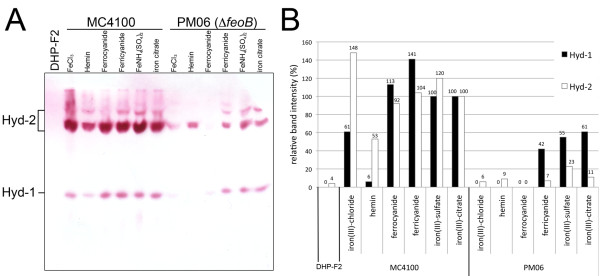
Effect of different iron supplements on Hyd-1 and Hyd-2 activities in PM06 (feoB::Tn5) after growth in M9 minimal medium. (A) Aliquots of crude extracts (25 μg) derived from DHP-F2 (negative control) the wild type (MC4100) and PM06 grown anaerobically in M9 minimal medium with glucose and the iron sources indicated were separated by non-denaturing PAGE (7.5% w/v polyacrylamide) and subsequently stained for hydrogenase enzyme activity (see Methods). The iron sources were the following: 7.5 μM FeCl3; 15.3 μM hemin; 50 μM iron citrate (C6H5FeO7) (Fe3+); 10 μM potassium ferrocyanide (K4[Fe(CN)6]) (Fe2+); 10 μM potassium ferricyanide (K3[Fe(CN)6]) (Fe3+); 10 μM Fe(NH4)(SO4)2 (Fe3+). (B) Densitometric quantification of the activity bands corresponding to Hyd-1 (black bars) and Hyd-2 (white bars) from the activity gel. Values were calculated as relative values compared to the intensity of the activity bands in the wild type (MC4100) grown with iron-citrate.